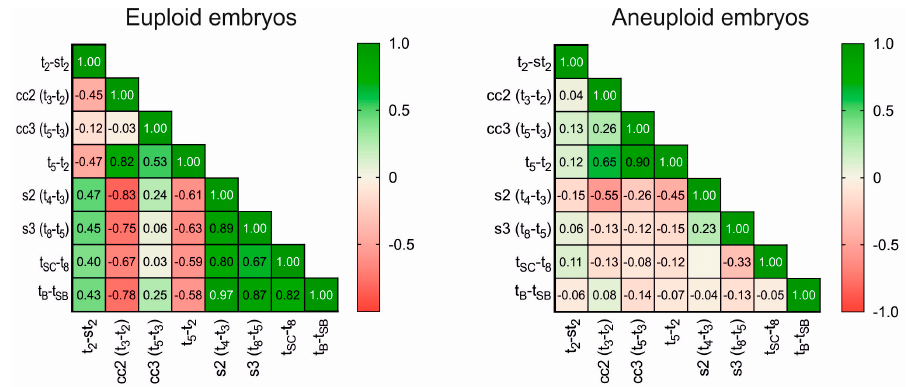
Figure 1. Correlation matrix of the studied interval parameters. The left panel shows the matrix obtained for euploid embryos; the right shows that obtained for aneuploid embryos. Numbers inside cells show r values. The color legend shows the degree of correlation: green (1.0), positive correlation; red ( − 1.0), negative correlation; 0, no correlation.